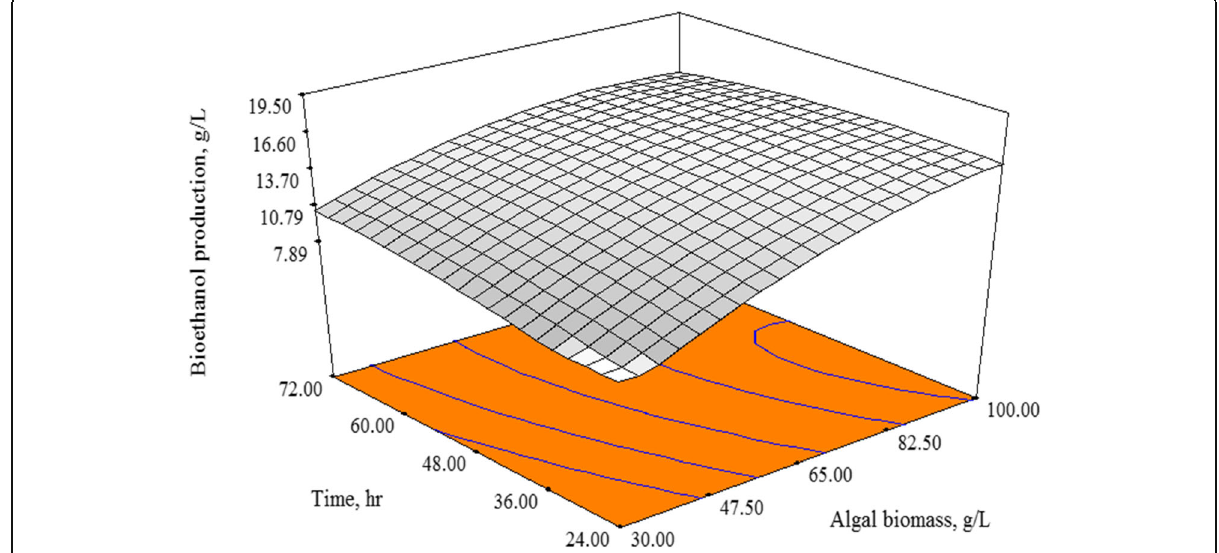
Fig. 3 The simultaneous effect of algal biomass and time on bioethanol yield at the central point of yeast volume %